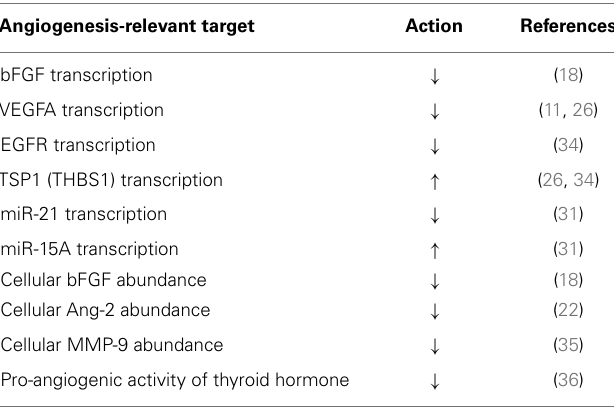
Table 1 |Transcriptional mechanisms by which Nanotetrac/tetrac is anti-angiogenic